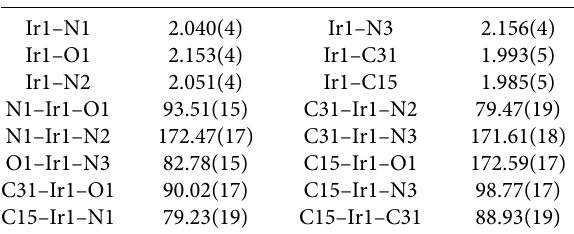
Table 2. Selected bond distances (Å) and angles (°) for complex 2b · H 2